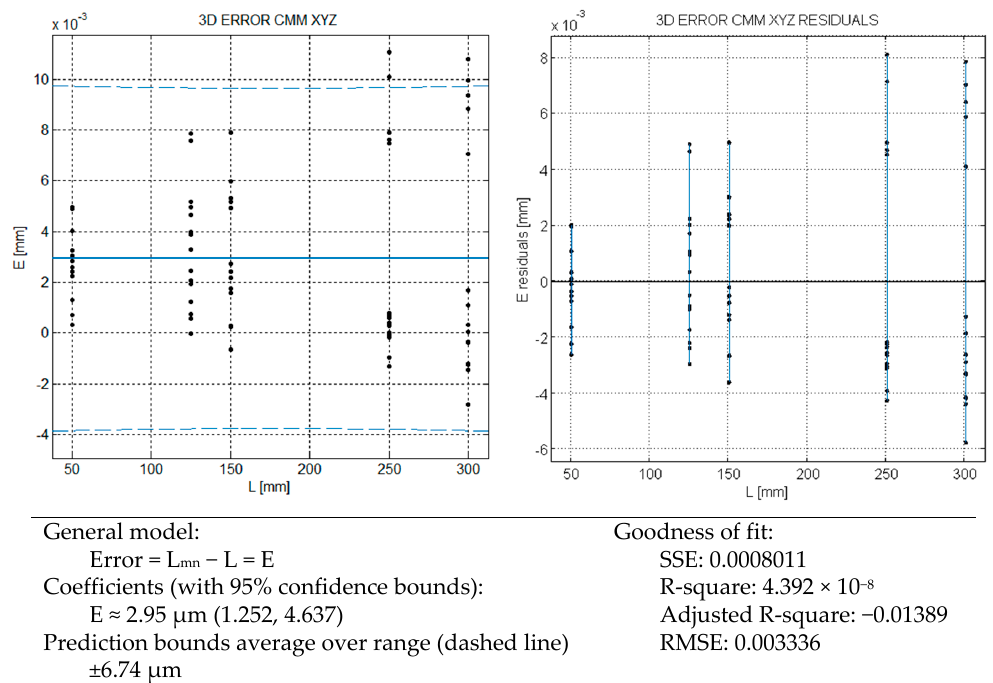
Figure 2. CMM bulk error model.